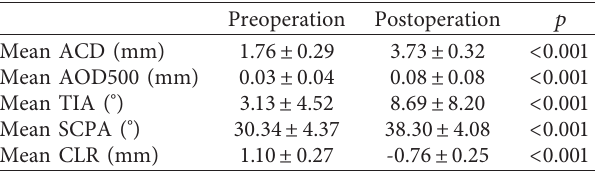
Table 3: Comparisons between preoperative and postoperative UBM